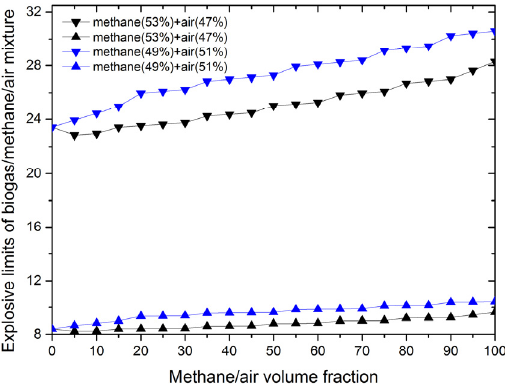
Figure 2. Explosive limits of biogas/methane/air mixture at different substitutions and supply ratios.